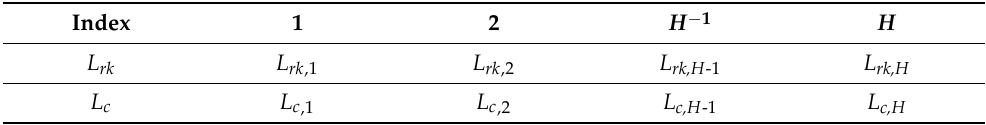
Table 1. The historical memory of L rk and L c